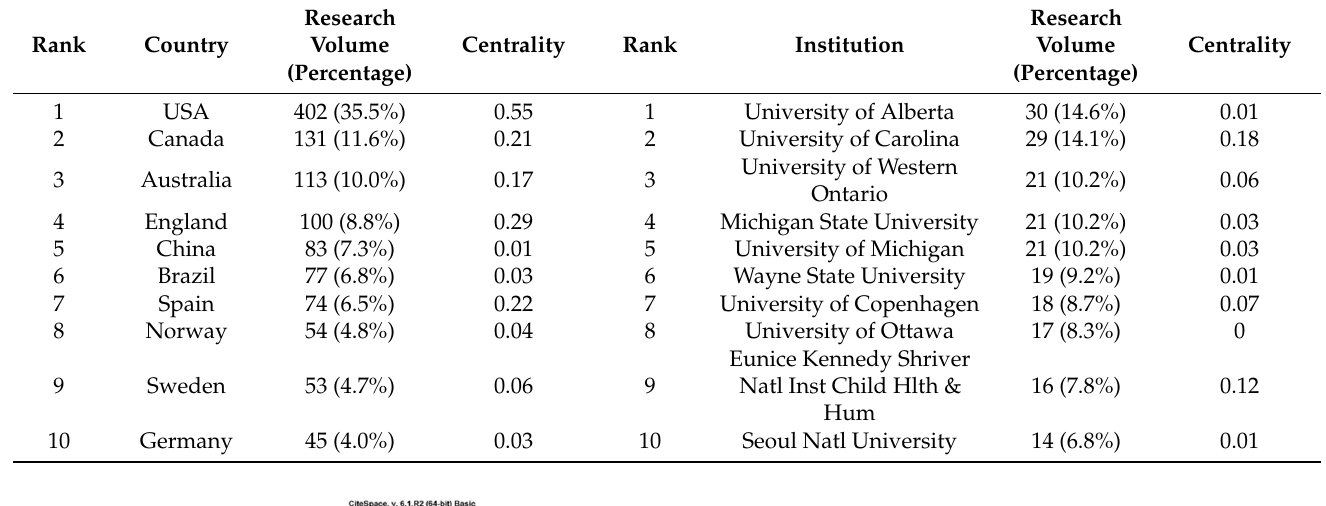
Table 1. Top 10 productive countries/institutions in research of physical activity during pregnancy.